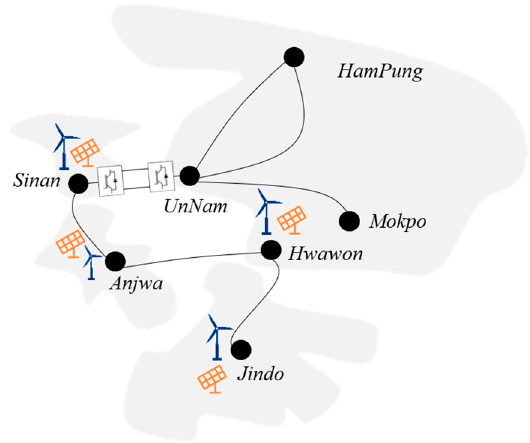
Figure 11. MVDC link candidate #2. UnNam-Sinan connection.